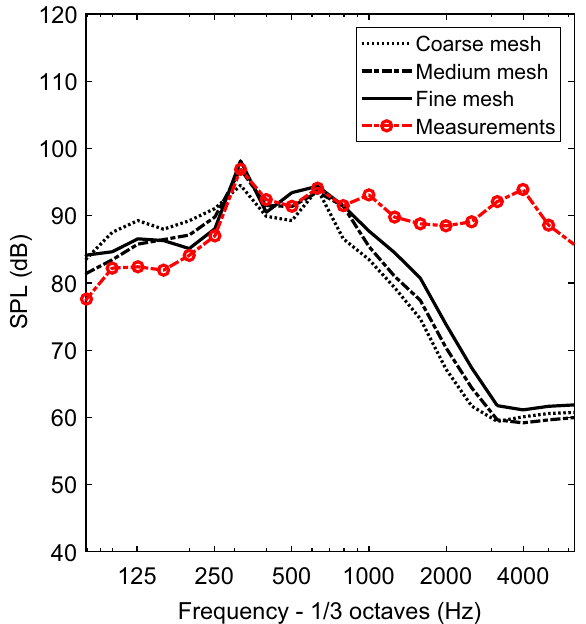
Fig. 15 SPL comparison of experimental [29] and numerical